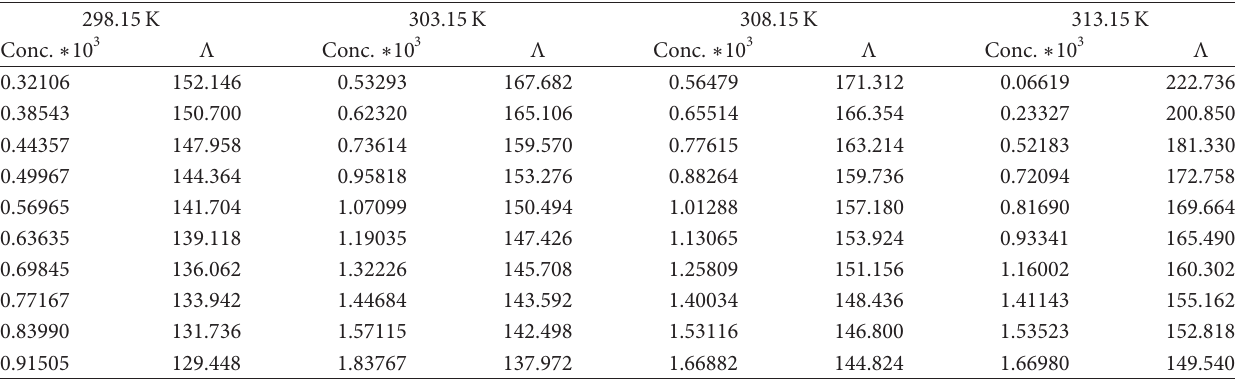
T 3: Experimental conductance data for Mg